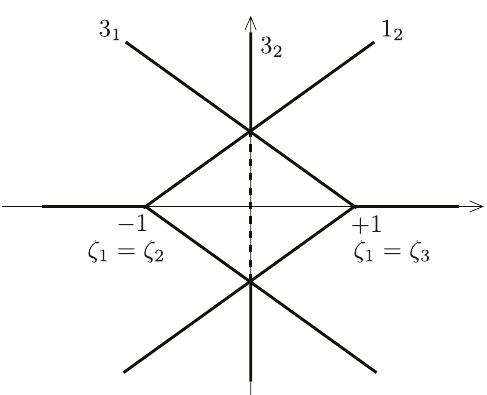
Figure 5 . Each Stokes lines are for a pair of two solutions. The numberings are denoting the two solutions. For 3 , the dominant solution is “ 3 ”, and the Stokes phenomena occurs for “ 3 ” 1 and “ 1 ”. The line denoted by 3 is the “new Stokes line”, but the dotted part does not cause the 2 Stokes